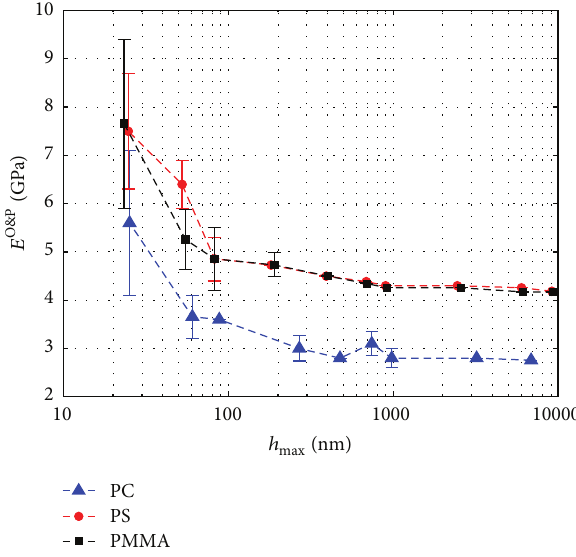
Figure 35: Elastic modulus of thermoplastic polymers according to Oliver and Pharr method [53] obtained with 10s loading, holding, and unloading times together with 0.1s −1 strain rate [15].